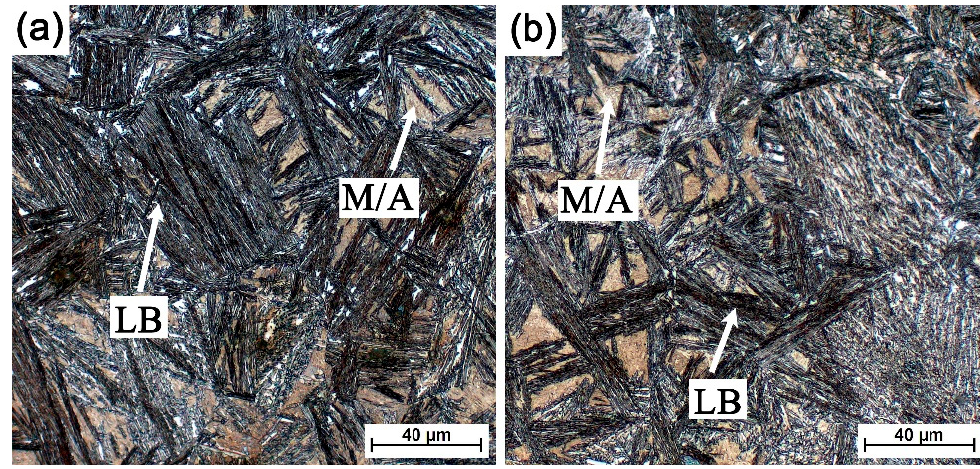
Figure 2. OM microstructure of substrates in samples ( a ) BA-2 and ( b ) NA-2.